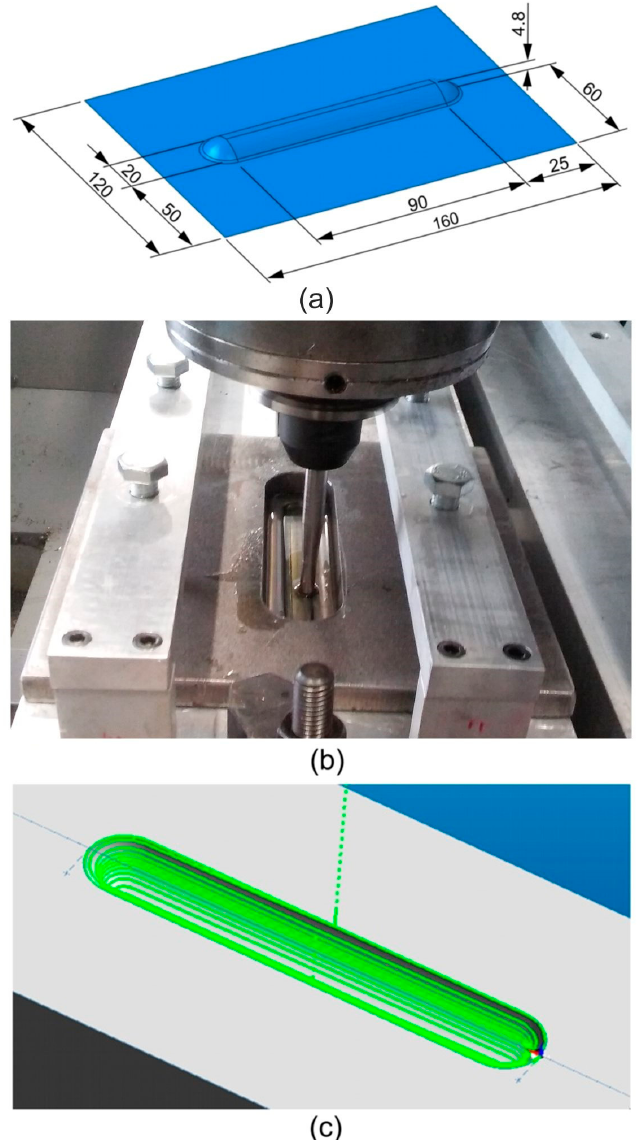
Figure 1. ( a ) Shape and dimensions of a rib-stiffened panel, ( b ) work-stand for single point incre- mental forming (SPIF) and ( c ) continuous spiral-shaped tool strategy generated in the EdgeCAM program.